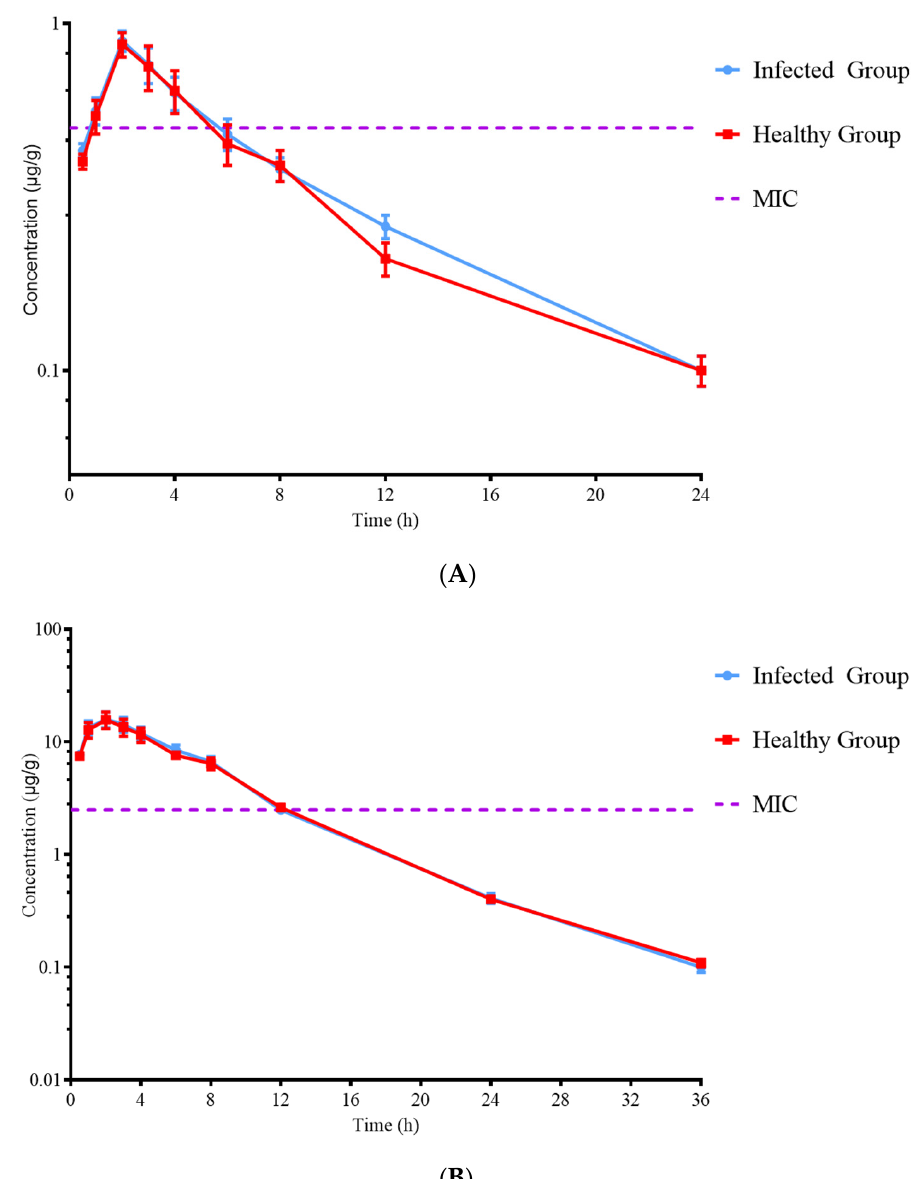
Figure 5. Concentrations of ADP ( A ) and SMZ ( B ) in plasma at various time points. After 24 h, the concentration of ADP and SMZ in plasma decreased below LOD, and after 36 h, the concentration of ADP and SMZ in PELF decreased below LOD. The fitting time of the model was 0–24 h, and the non-compartment model was used. The parameters of ADP, SMZ, and ADP/SMZ compound in plasma and PELF were simulated with WinNonlin (v.5.2.1 US Certara Pharsight ® ). The parameters are shown in Tables